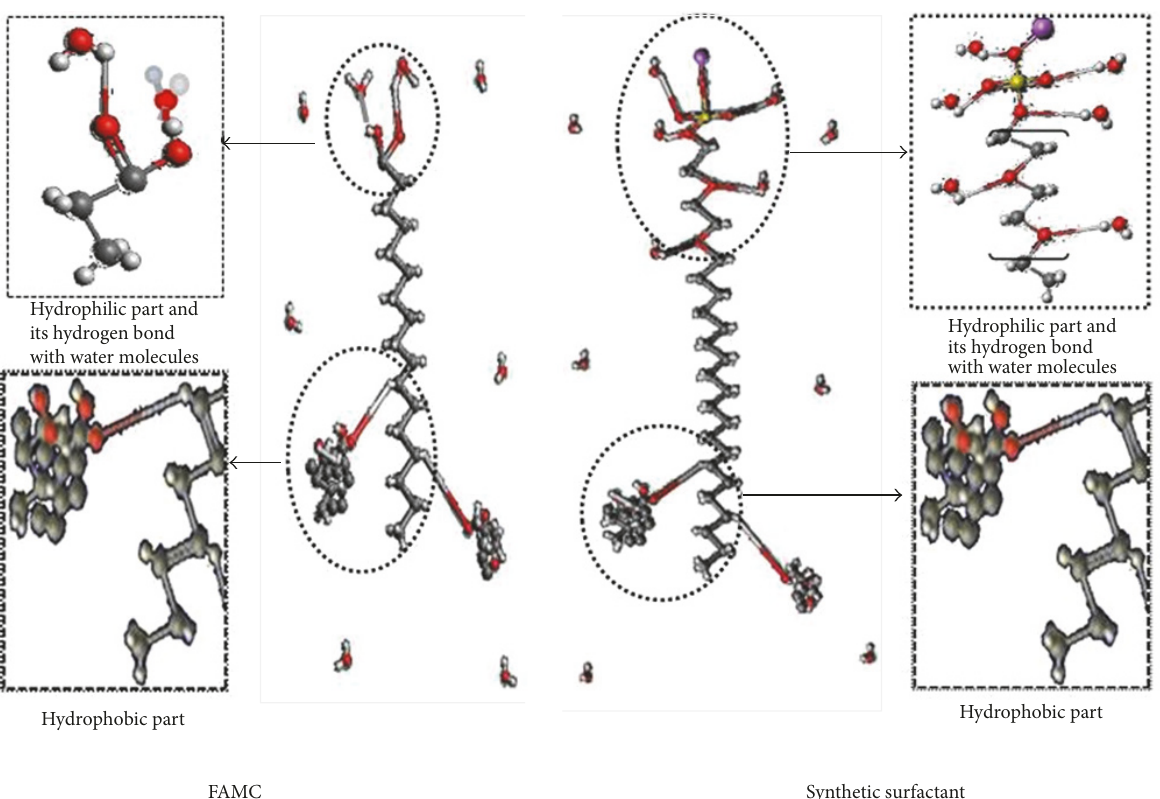
Figure 5: Stick-and-ball representations of the theoretical interactions between ink particle, FAMC, and synthetic surfactant molecules.